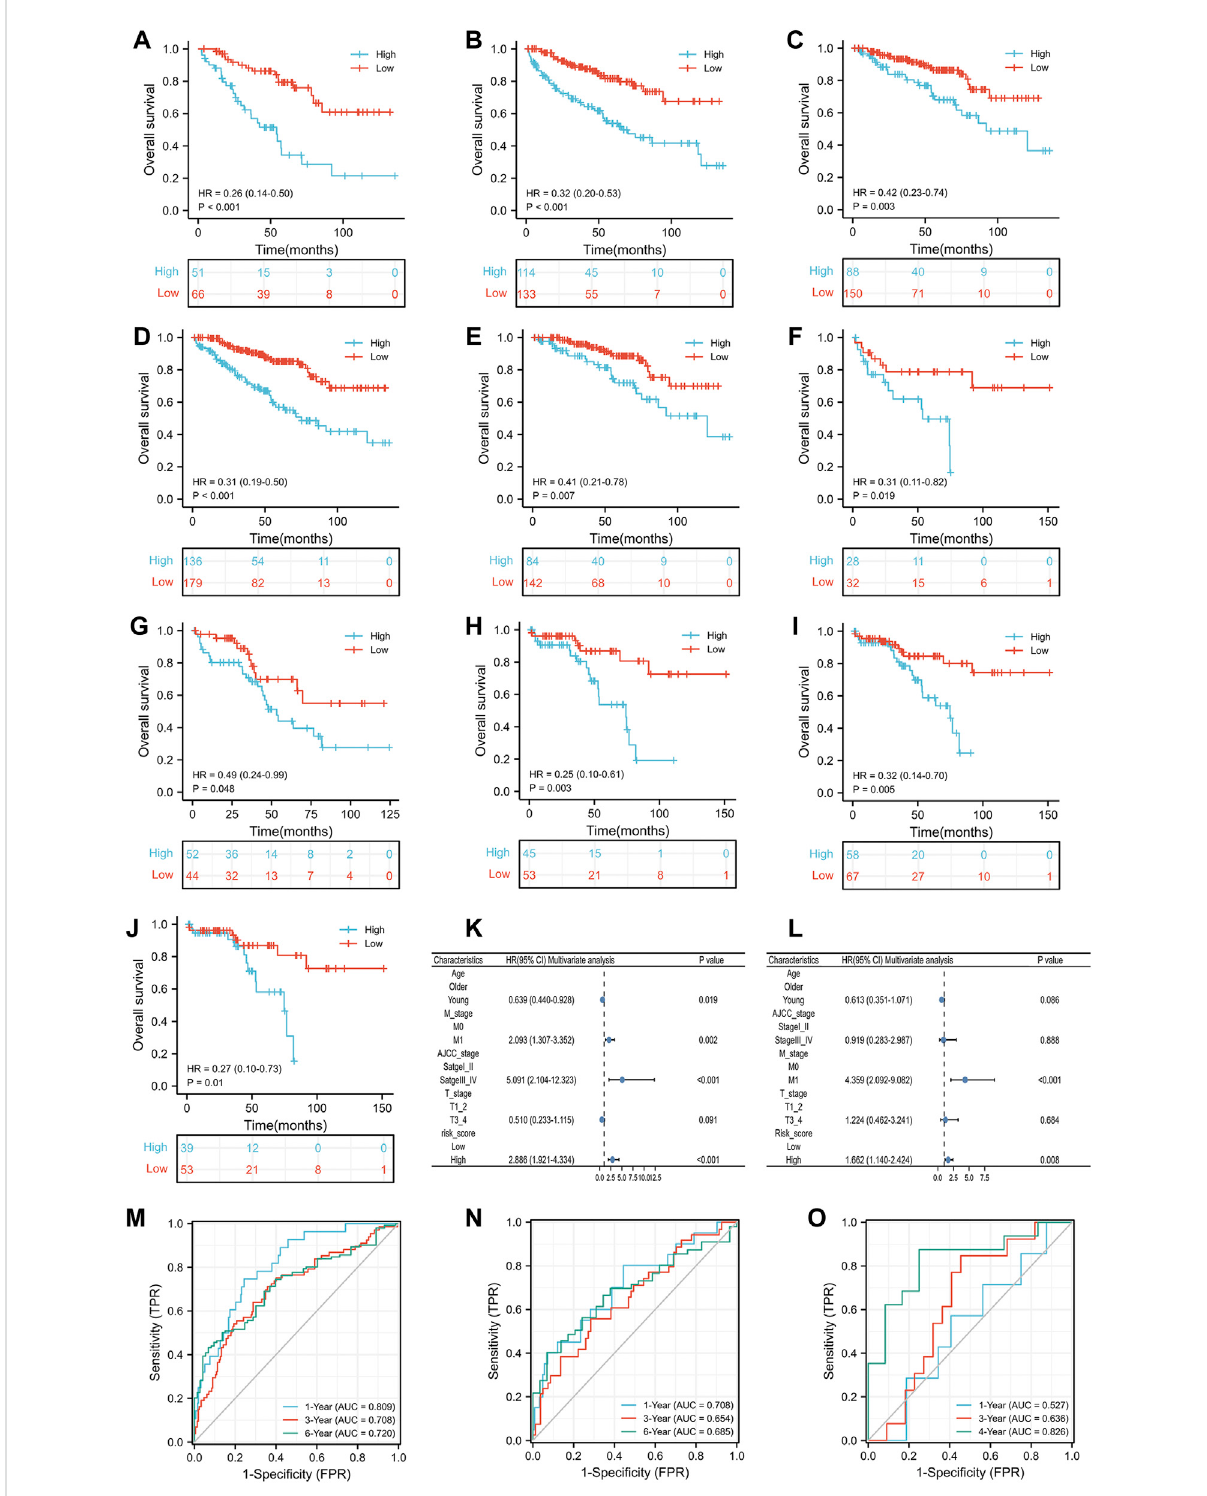
FIGURE 5 The prognostic ability of the risk scores: Kaplan-Meier analysis results of subgroups in TCGA training group: female (A) , male (B) , T1_2 (C) , M0 (D) and AJCC stage I-II (E) ; Kaplan-Meier analysis results of subgroups in TCGA test group: female (F) , male (G) , T1_2 (H) , M0 (I) and AJCC stage I_II (J) ; Results of multivariate Cox regression model for parameters in TCGA training group (K) ; Results of multivariate Cox regression model for parametersinTCGAtestgroup (L) ;ReceiveroperatingcharacteristiccurveanalysisresultsofTCGAtraining group (M) ,TCGAtestgroup (N) and GSE29609 (O)